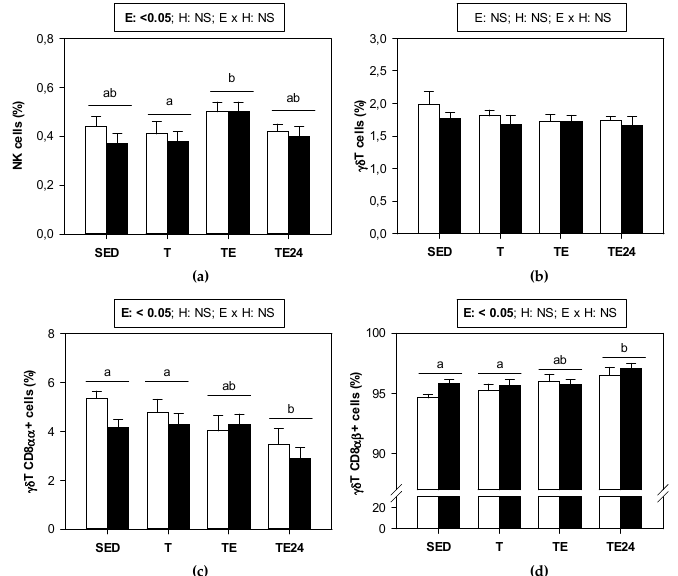
Figure 5. Proportion of the minor lymphocyte populations in mesenteric lymph nodes: ( a ) NK cells, ( b ) γδ T cells, ( c ) γδ T CD8 αα + cells, and ( d ) γδ T CD8 αβ + cells. The non-supplemented groups are represented by white bars and the hesperidin-supplemented groups by black bars. SED = sedentary groups; T = trained groups; TE = T groups with an additional exhaustion test; TE24 = TE groups 24 h after the exhaustion test. E = exercise; H: hesperidin supplementation; E × H = interaction between E and H; NS = no significant differences. Data are expressed as mean ± SEM ( n = 8). Statistical analysis (ART-ANOVA test): Different letters indicate significant differences due to exercise.